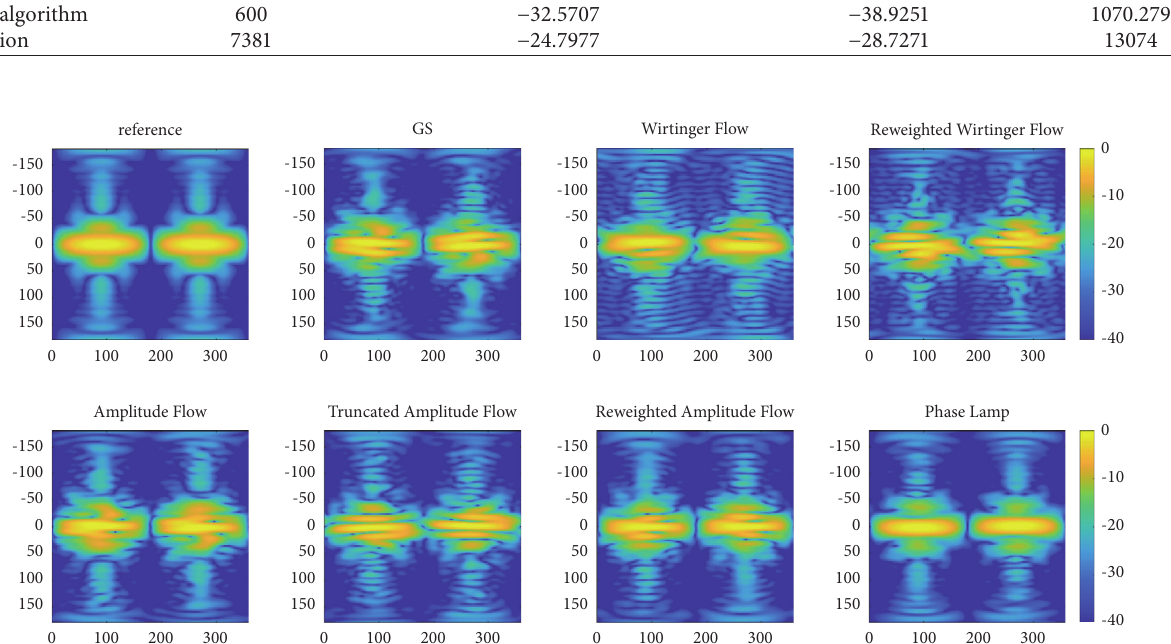
of horn antenna by adopting other phase recovery algorithms. θ